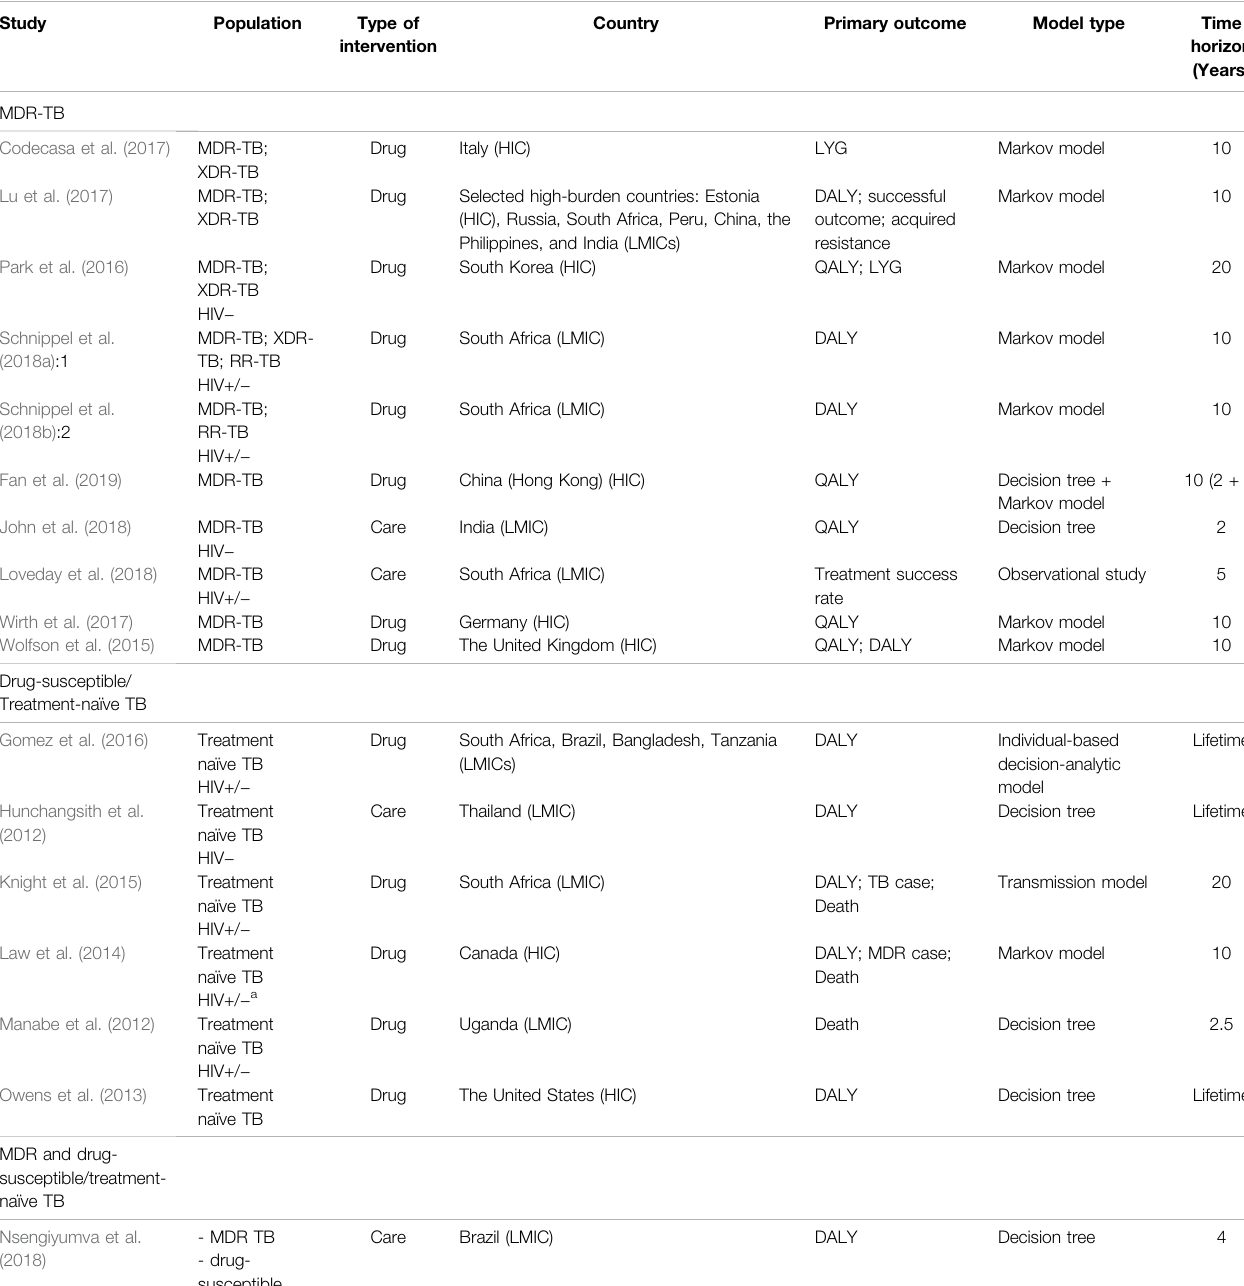
TABLE 1 | Characteristics of the included studies ( N (cid:1)